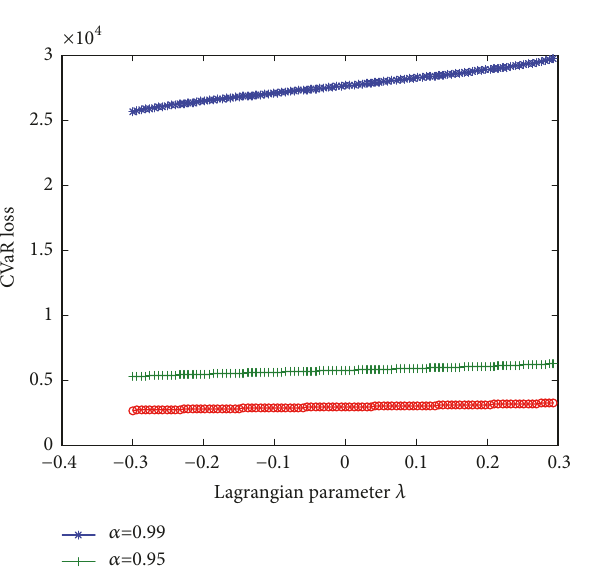
Figure 5: CVaR loss under different 𝜆 .